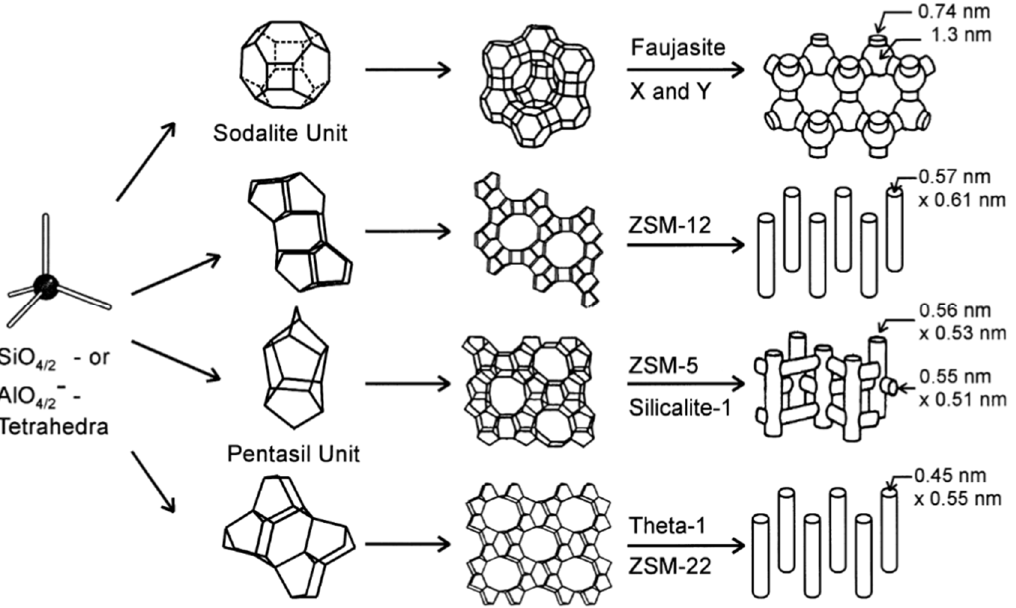
Figure 1. Structures of four selected zeolites (from top to bottom: faujasite or zeolites X, Y; zeolite ZSM-12; zeolite ZSM-5 or silicalite-1; zeolite Theta-1 or ZSM-22) and their micropore systems and dimensions. Reprinted with permission from Ref. [24]. 2000, Elsevier.